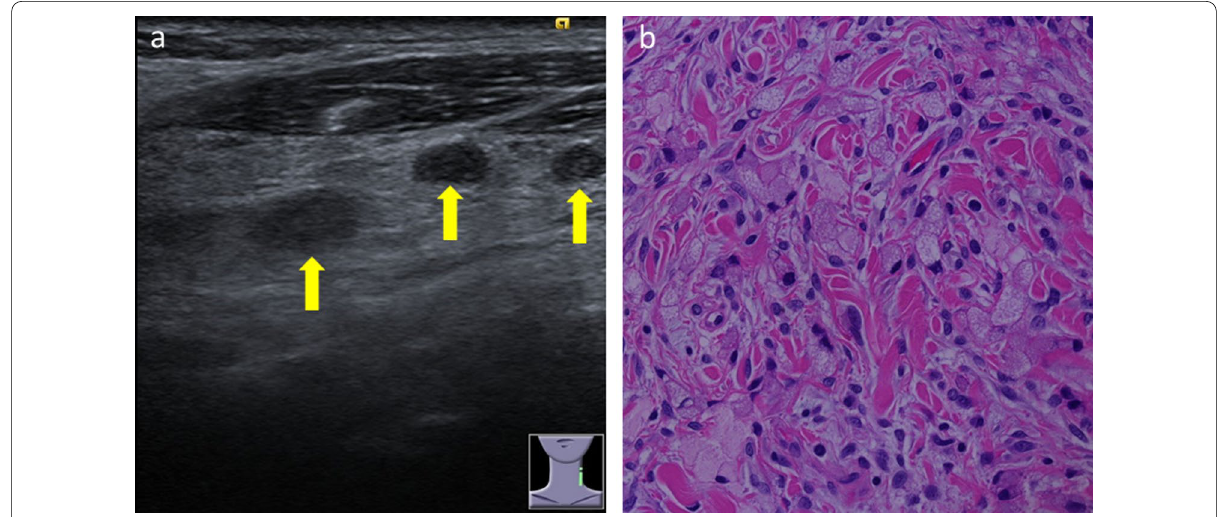
Fig. 1 Ultrasonography and pathological findings in cervical lymph nodes. a Ultrasonography showed three pieces of lymph node enlargement in left cervical area (arrow). b Pathological findings revealed signet-ring cell and a poorly differentiated adenocarcinoma (